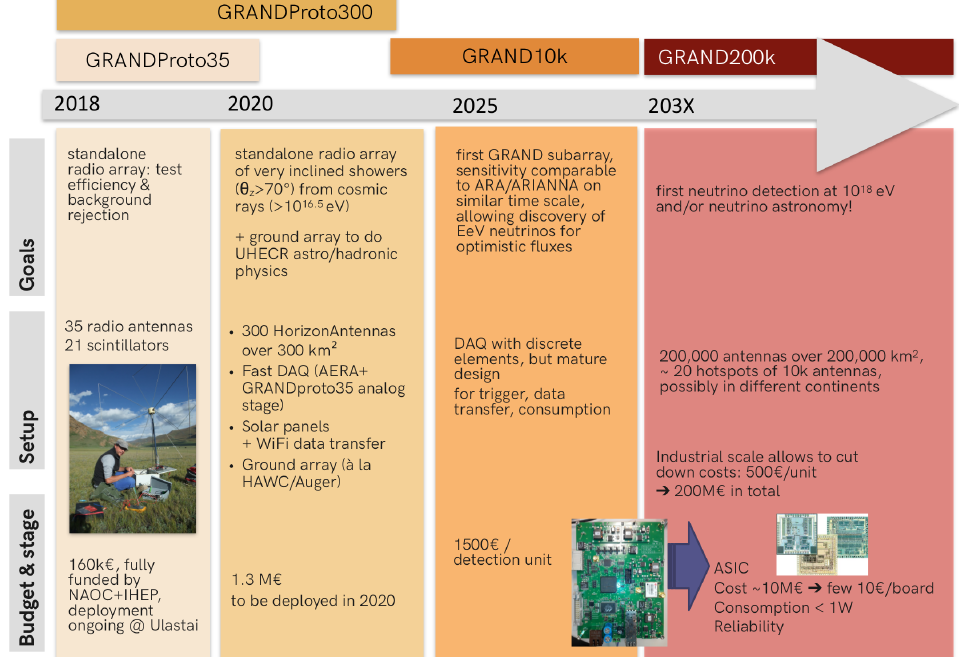
Figure 5: GRAND roadmap [ 1